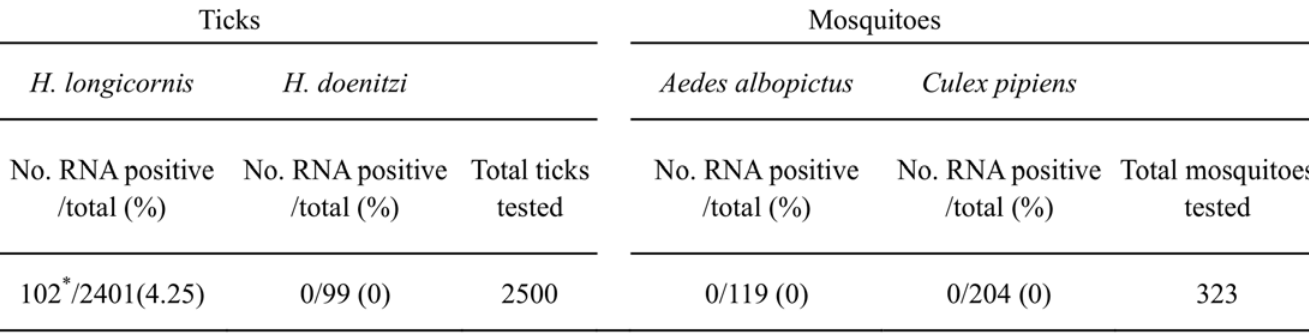
Fig 4. SFTSV viral RNA detected in ticks and mosquitoes in natural infection study. * 102 H . longicornis ticks included in 12 tick samples were viral RNA positive.